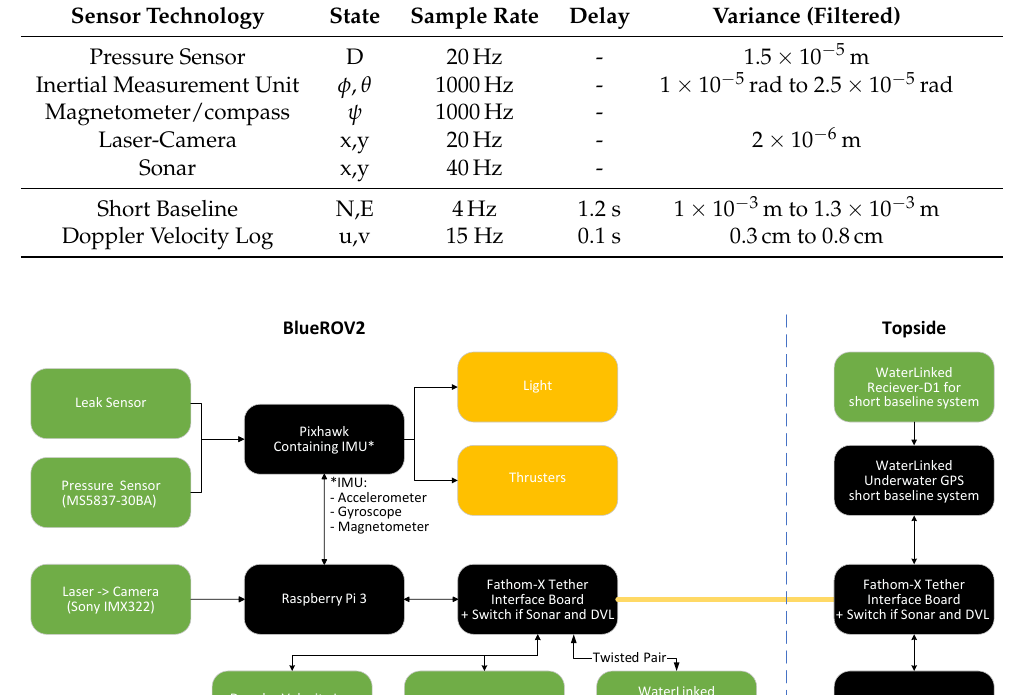
Table 1. List of common sensors used for the BlueROV2.